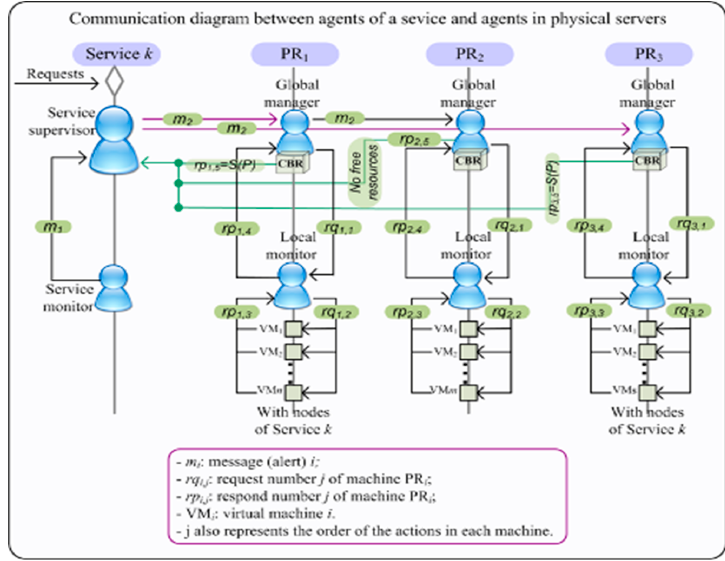
Figure 4. Diagram of the collaborative agents shown in Figure 2 communicating to reach a solution S(P) to the request carried out by the service k. Table 1. Summary of information on physical servers.